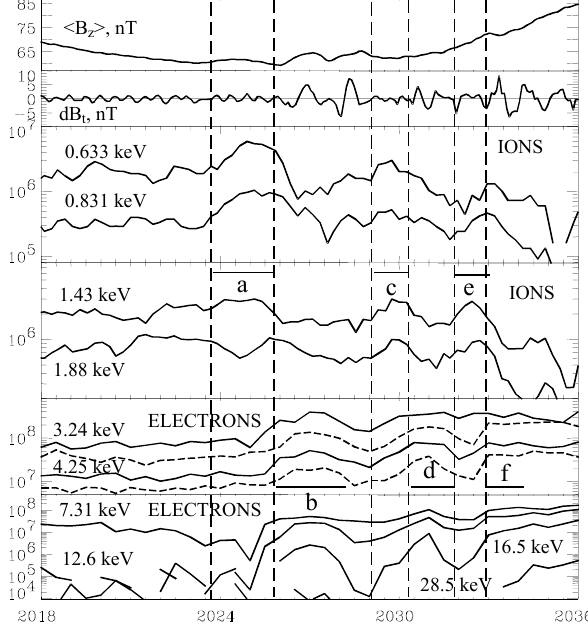
Fig. 6. The alternation of the low-energy ion and electron bursts during the substorm on 12 March